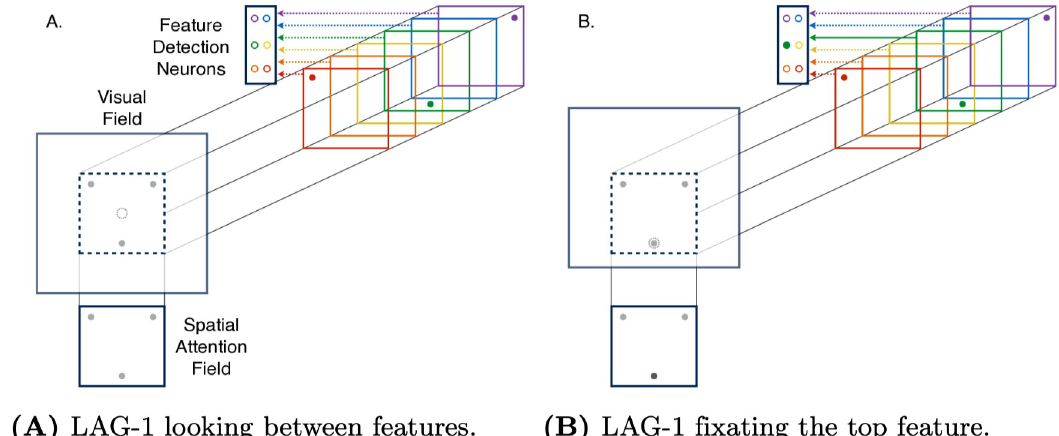
Fig 2. Information processing schema. Schematic of the relationships between experiment input, the Feature Detection Neurons, Visual Field, and the Spatial Attention Field. A) The fovea is indicated by the dashed grey circle in the center of the Visual Field. B) After an eye movement to the bottom middle feature, the green sensitive Feature Detector is activated and the Spatial Attention Field is boosted at its associated location. The Visual Field is coding spatial information in retinotopic coordinates while the Spatial Attention Field is coding information in spatiotopic